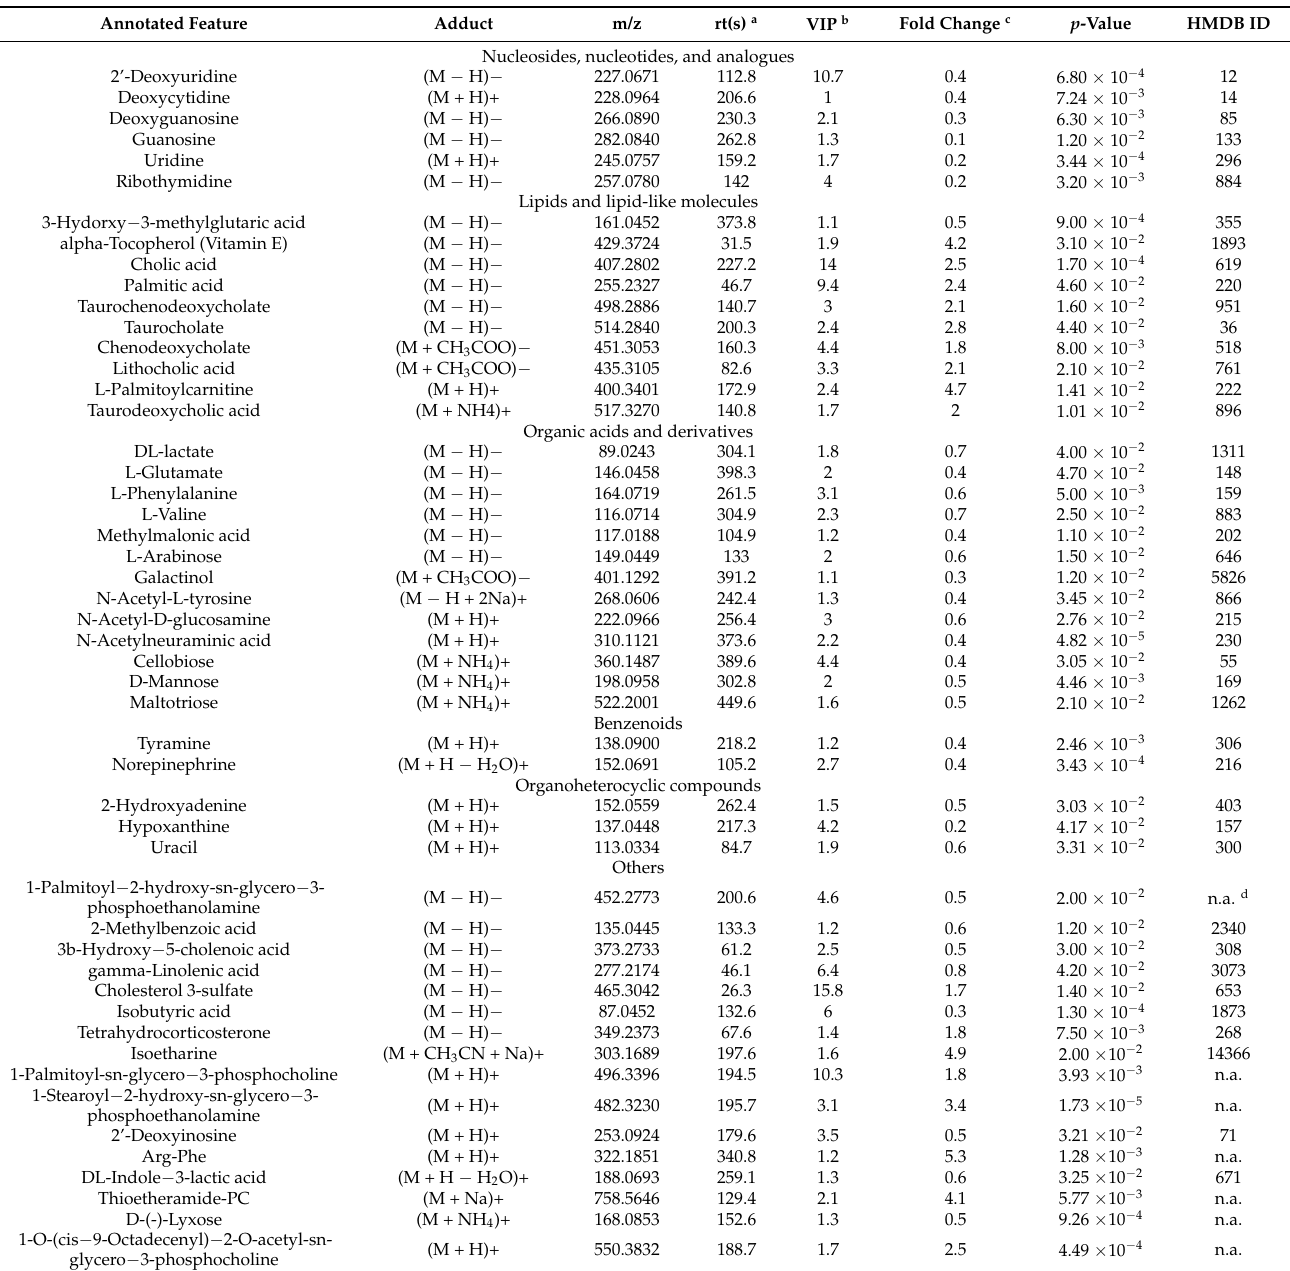
Table 1. Significantly dysregulated ( p < 0.05) metabolomic classes and the corresponding metabolites in mice exposed to